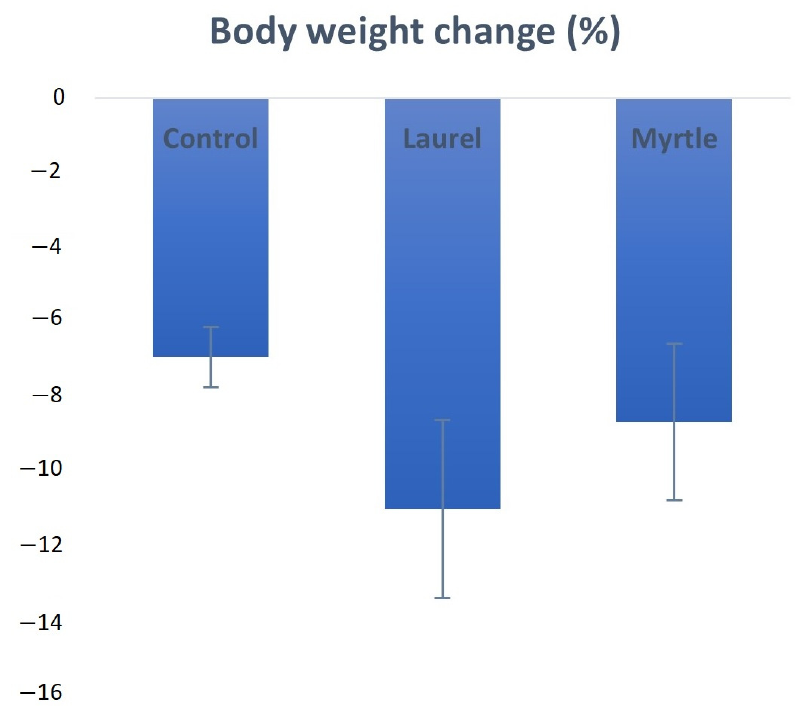
Figure 3. Evolution of the body weights of rats treated with laurel and myrtle EOs. Female rats ( n = 5) were administered ig with laurel and myrtle EOs at a dose of 1 μ L per 1 g of rats once daily for 14 days. Laurel and myrtle EOs were mixed with sunflower oil (1:1) and the total daily volume per rat was 0.5 mL. The control group was treated ig with 0.5 mL of sunflower oil. The results are expressed as the mean value of each experimental group ± SEM. Abbreviations: EOs, essential oils; ig , intragastric, SEM, standard error of the mean.